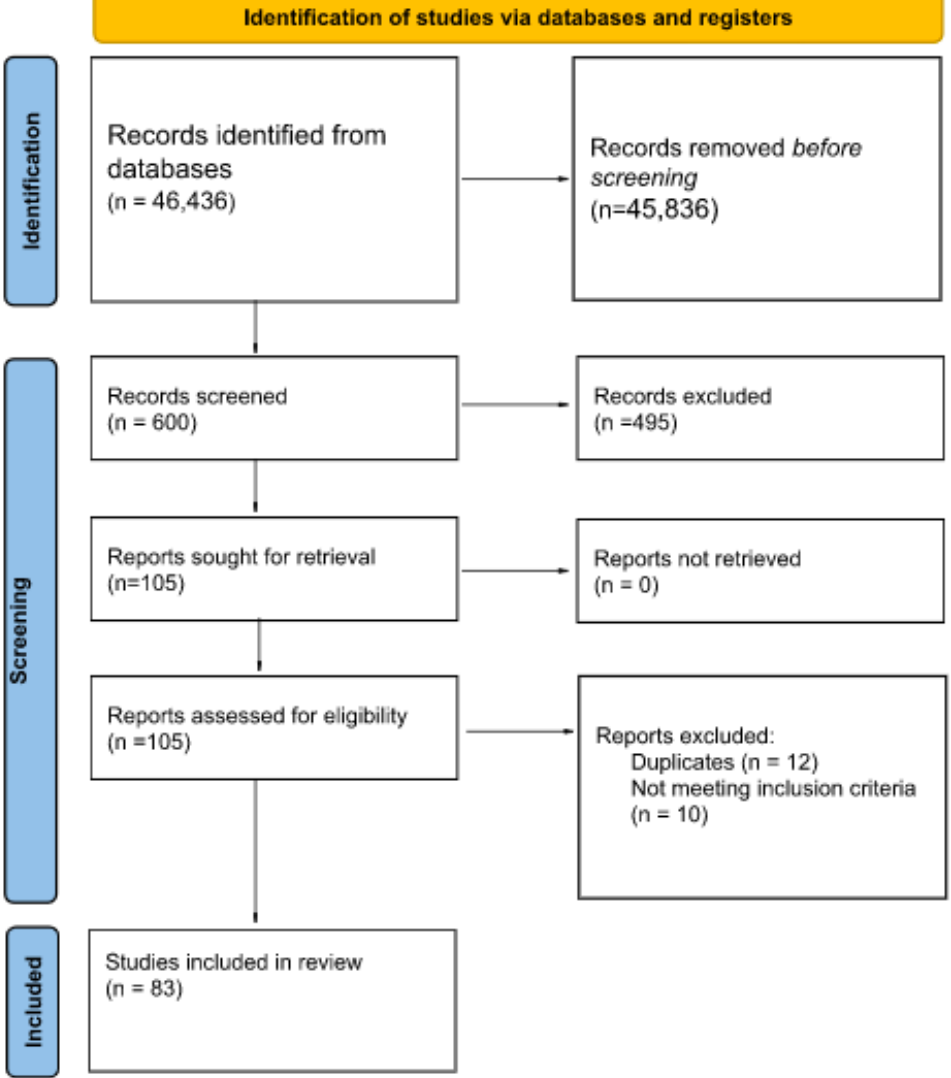
Figure 1. PRISMA diagram of the systematic literature review ( n — number of records).